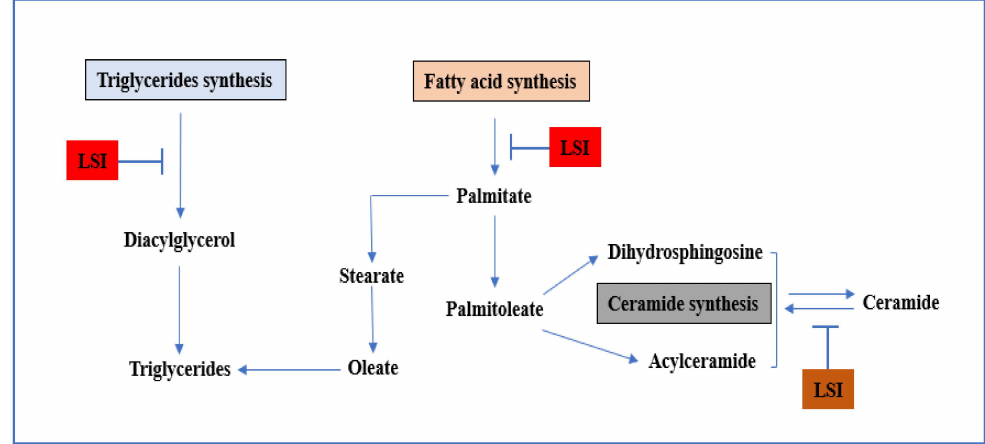
Figure 7. Mechanism of action of